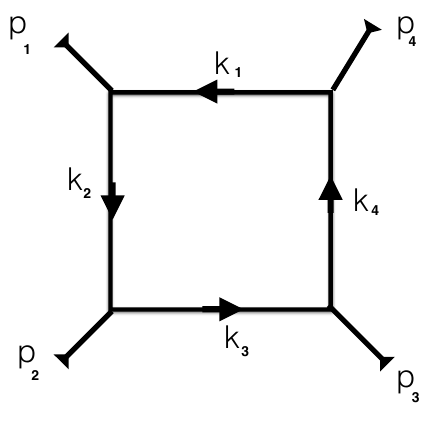
Figure 2 . The one-loop